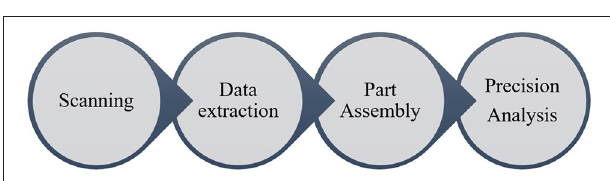
FIGURE 3 | Flowchart for the procedure followed in the precision